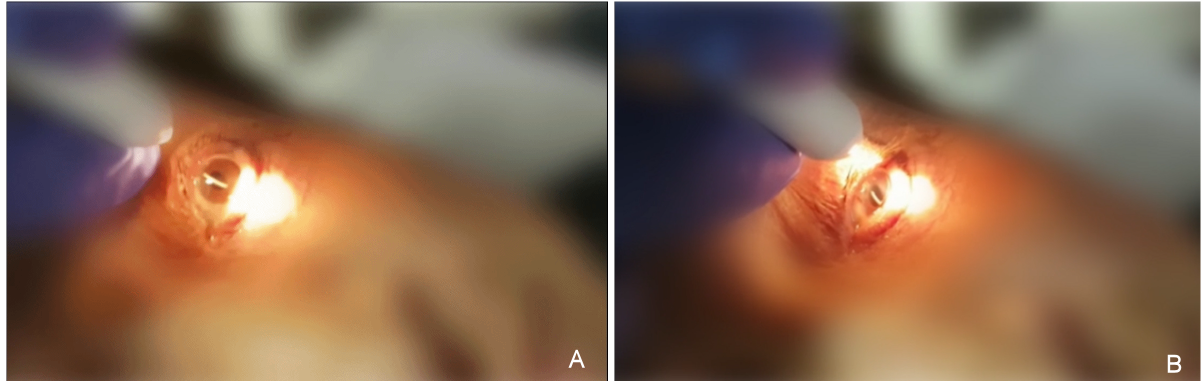
Figure 2: The images show the actual moment when the dexamethasone implant moves from the anterior to the vitrous chamber through the pupil. A) Looking up, the implant moves to the superior angle. B) Looking down, the implant migrates